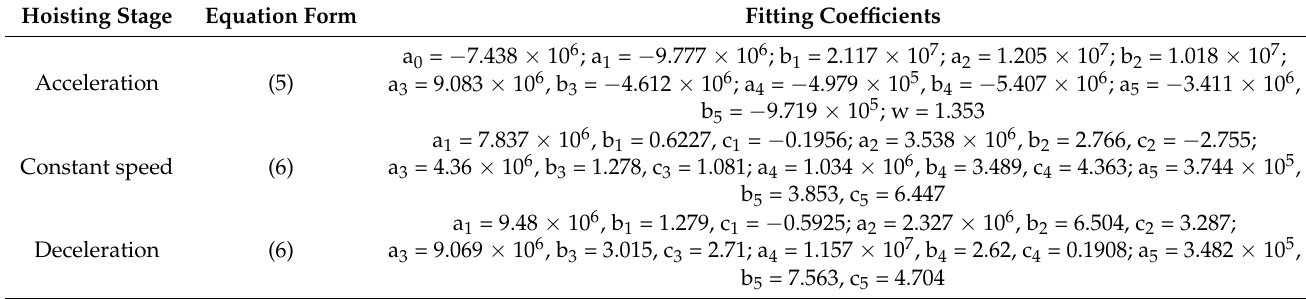
Figure 4. Evolutions of dynamic torque exerted on the drum during emergency braking. ( a ) Dynamic torque exerted on the drum in cases of different hoisting stages; ( b ) fitting curve of dynamic torque in the acceleration stage of hoisting; ( c ) fitting curve of dynamic torque in the constant speed stage of hoisting. Table 2. Evolution equations of dynamic torque exerted on the drum and corresponding fitting coefficients during emergency braking in cases of distinct hoisting